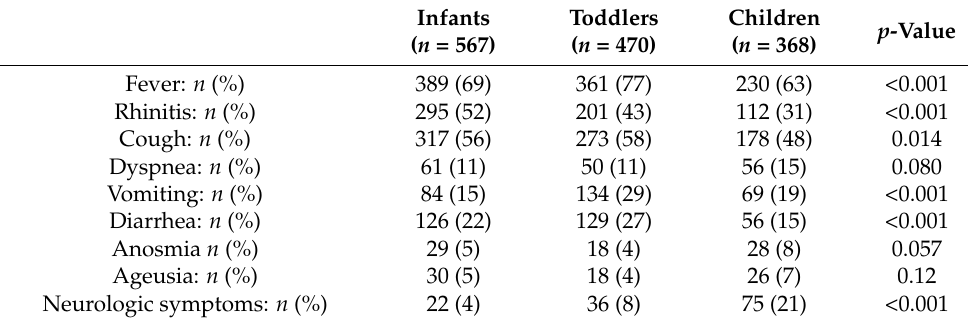
Table 2. Clinical characteristics of COVID-19 in infants, toddlers, and children.